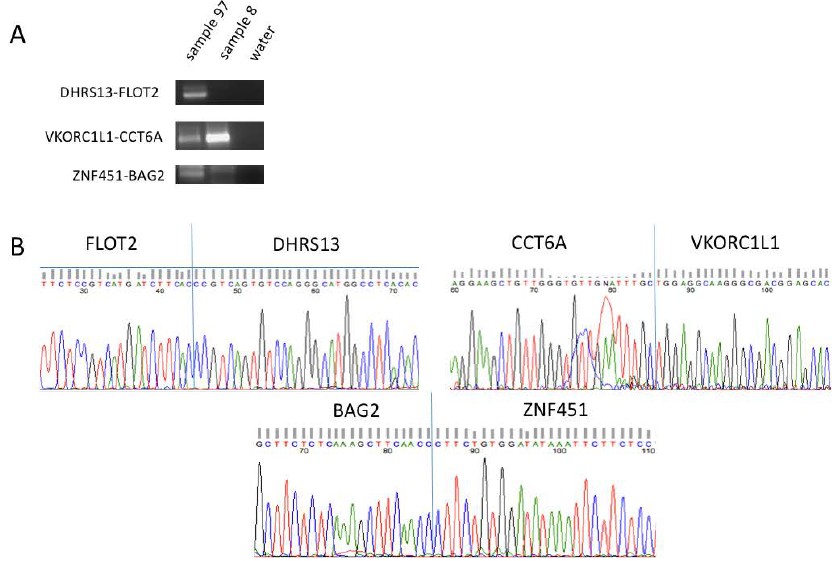
Figure 2. Confirmation of fusion RNAs. ( A ) Representative examples of fusion RNAs amplified by RT-PCR and separated by gel electrophoresis before being purified and processed for Sanger sequencing. The size of the fusion RNAs fall within 100–300 bp. ( B ) Sanger sequencing data highlighting the junction sequence for the same representative